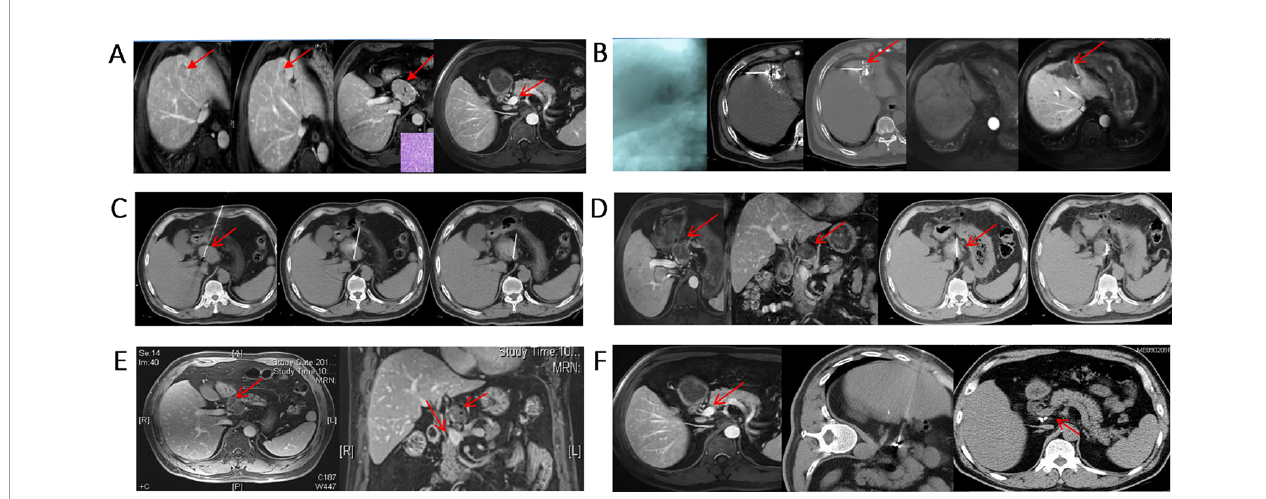
FIGURE 7 | Minimally invasive, comprehensive treatment for metastatic lymph nodes. (A) S4 HCC with metastatic lymph nodes in the portal vena cava space that were pathologically con fi rmed as HCC. The AFP level was 439 ng/mL before treatment; (B) Two weeks after TACE treatment, subsequent RFA was performed; (C) RFA ablation of hepatic portal metastatic lymph nodes; (D) Lymph nodes were basically inactivated, and 125I particles were implanted in the remaining portion; (E) Metastatic lymph nodes were completely necrotic, and the AFP level decreased to 14 ng/mL; (F) After adjuvant CIK treatment, the metastatic lymph nodes were completely inactivated, and AFP was further reduced to 2 ng/mL. The patient is still alive 10 years after treatment.